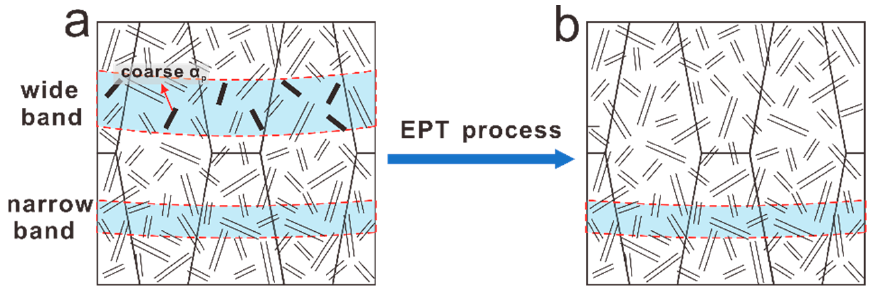
Figure 11. Schematic diagram of microstructural evolutions: ( a ) as-deposited sample, ( b ) EPT sample.